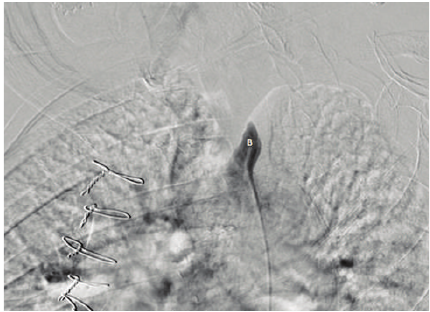
Figure 4: Selective subclavian angiogram. (B) Inability of the guide wire to pass through the completely occluded subclavian artery.